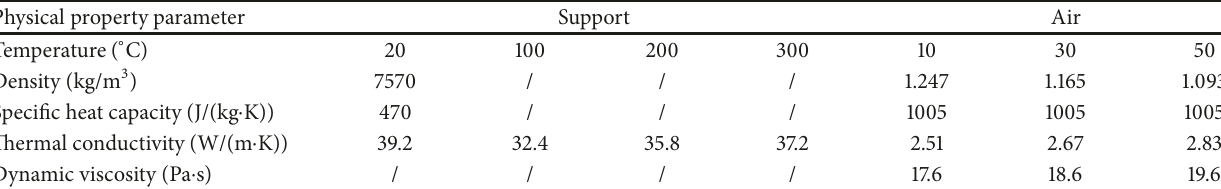
Figure 5: Meshing of the support. Table 2: The physical property parameter of support and air.